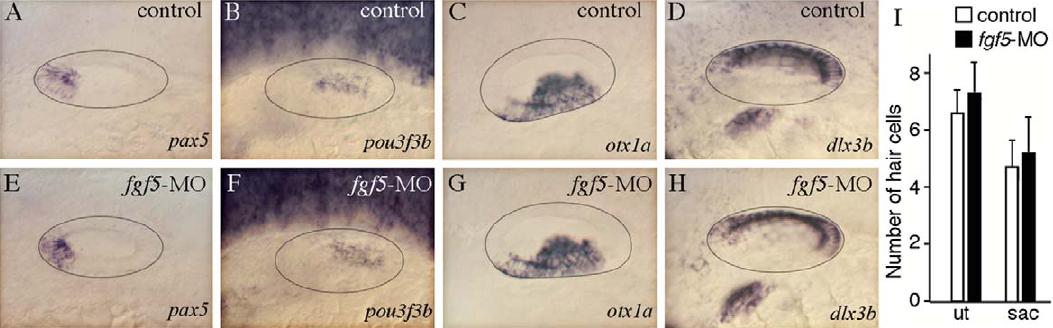
Figure 7. Normal axial patterning in fgf5 morphants. (A–H) Expression of regional patterning markers in control embryos (A–D) and fgf5 morphants (E–H). Expression of pax5 (A, E) and pou3f3b (B, F) labels anterior and posterior regions, respectively. Expression of otx1a (C, G) and dlx3b (D, H) labels ventromedial and dorsolateral regions, respectively. The otic vesicle is outlined. Images show dorsolateral views with anterior to the left. (I) The total number of hair cells in the utricular (ut) and saccular (sac) maculae of control embryos and fgf5 morphants at 32 hpf. Data were obtained by counting GFP-positive hair cells (mean of total number 6 standard deviation) in the sensory epithelia of brn3c:Gfp transgenic embryos. Data show means and standard deviations from 20 specimens each. Differences between control and experimental specimens were not statistically significant (p=0.16 for the utricle, p=0.67 for the saccule) based on Student’s t tests.